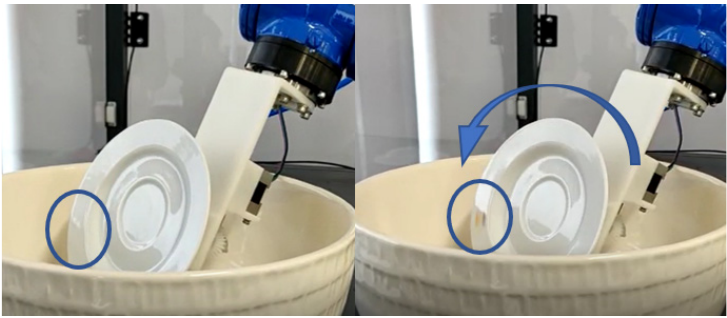
Figure 5. Simulation of the saucer’s diving. Source: (Own).